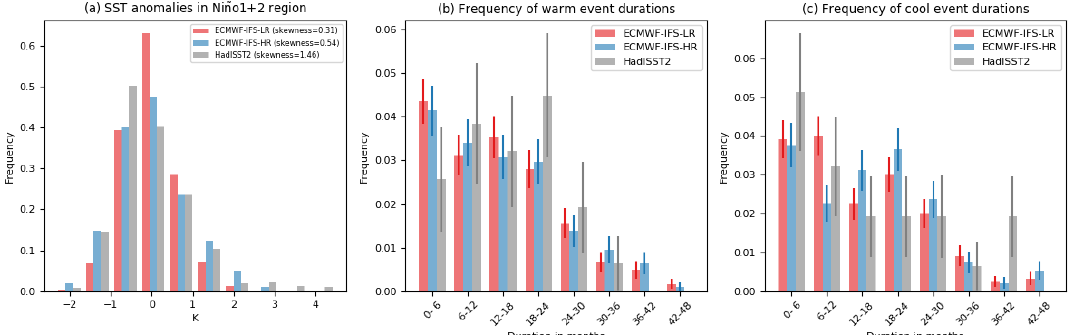
Figure 16. (a) Histogram of 3-month running mean SST anomalies relative to 1981–2010 in the Niño1+2 region (90–80 ◦ W and 10 ◦ S–0). Frequency of (b) warm and (c) cool event durations determined from the time series plotted in Fig. 15 and additional ensemble members from hist-1950, control-1950, and spinup-1950. Error bars in panels (b) and (c) represent a bootstrap estimate of the standard error in frequency and are derived by resampling from the available events 10000